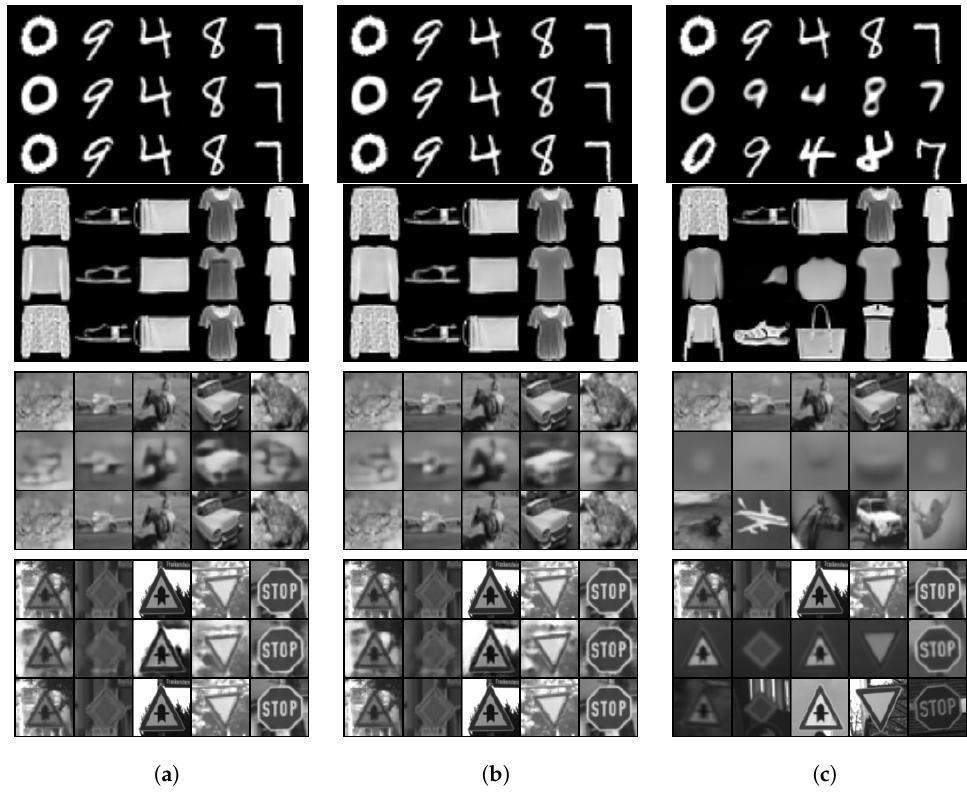
Figure 4. Comparison of the input (first row), reconstruction (second row) and target (third row) of the training data after the last epoch. The results are for different autoencoder models for different datasets: MNIST (first block), Fashion-MNIST (second block), CIFAR10 (third block) and GTSRB (fourth block). We either used the triplet loss (TAE), the second variation of the PIRL (II-AE) or just the vanilla reconstruction loss (AE). ( a ) AE. ( b ) TAE. ( c ) II-AE